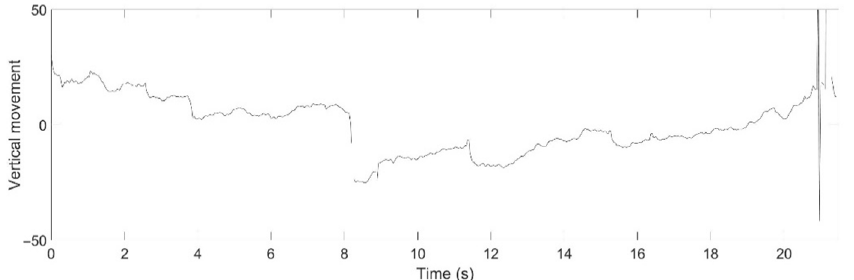
Figure 14. Nystagmus waveform from the proposed method for Video No. 1, vertical movement of the pupil.